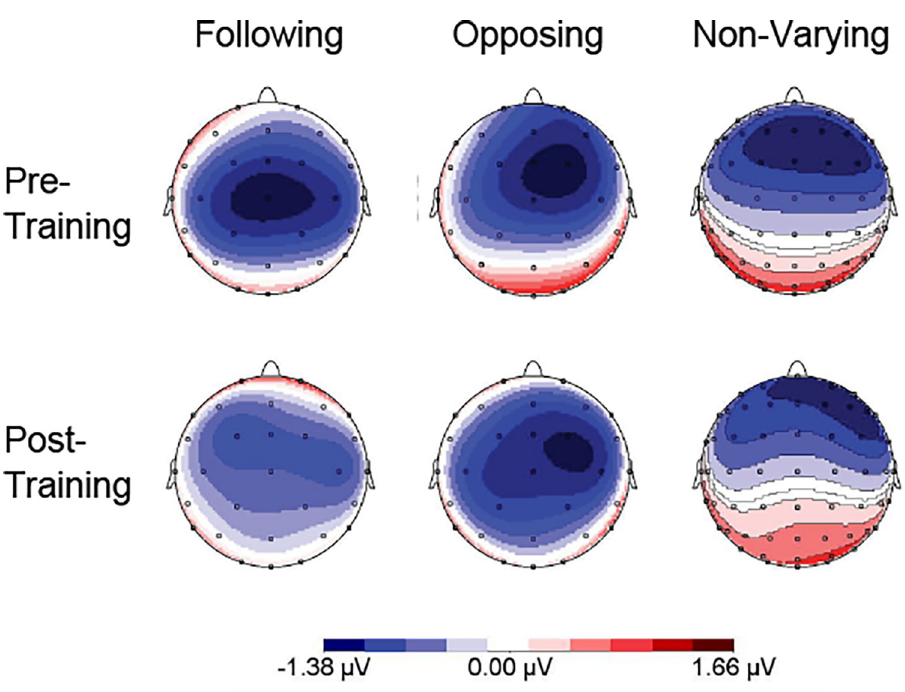
Fig 1. Mapping view of the N1 response. Mapping view of the grand averaged ERPs from 130–160 ms pre-training (top row) and 115–135 ms post-training (bottom row) for the following, opposing, and non-varying groups.